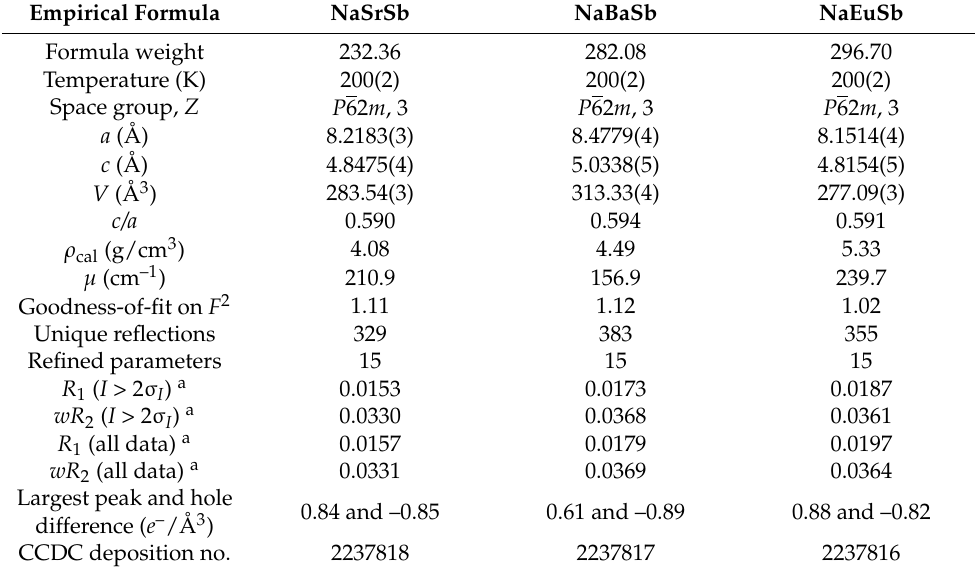
Table 1. Selected single-crystal data collection and structure refinement parameters for NaSrSb, NaBaSb and NaEuSb. All three data sets were collected with Mo K α radiation, λ = 0.71073